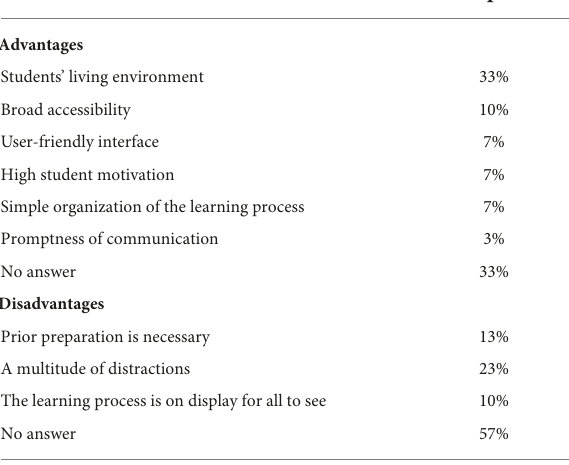
TABLE 5 Advantages and disadvantages of social media (teachers’